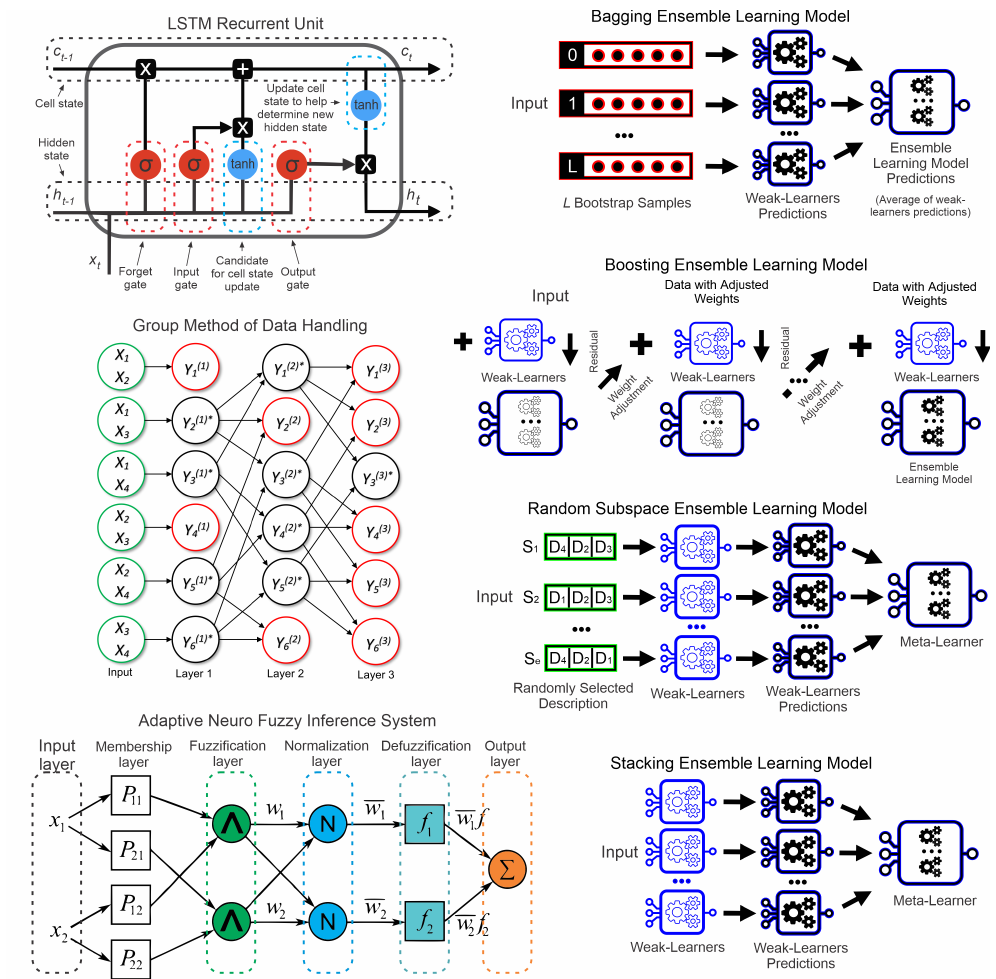
Figure 3. Structure of the considered